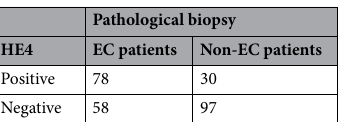
Table 4. The four-fold table of the HE4-based diagnostic test. EC endometrial cancer.